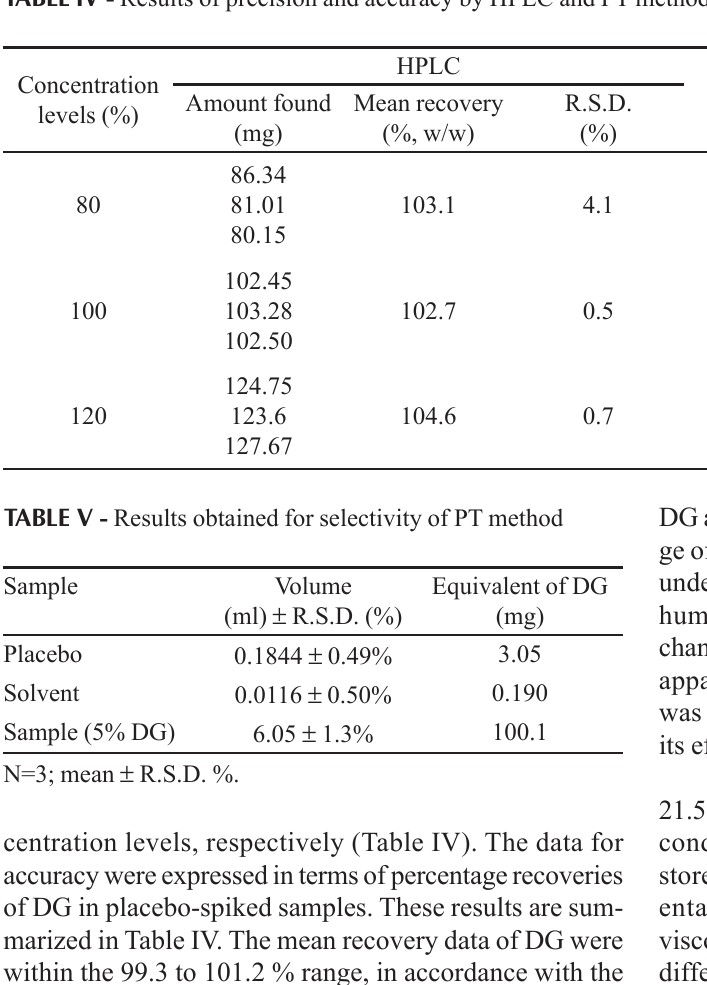
TABLE IV - Results of precision and accuracy by HPLC and PT methods (n=3) Concentration